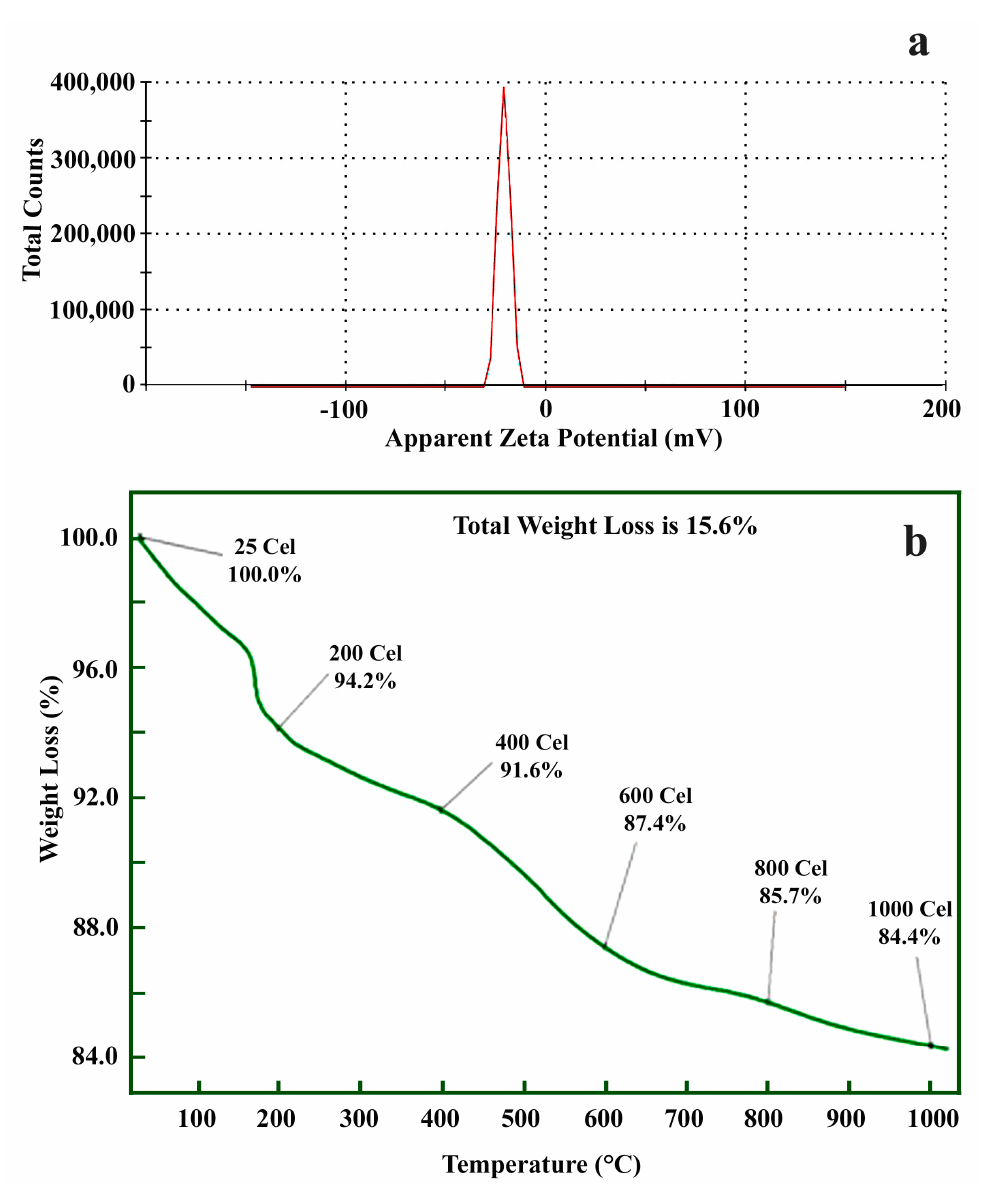
Figure 4. ( a ) Zeta potential analysis and ( b ) TGA analysis of green synthesized nano-ZnO particles using C. verrucosa leaf extract.